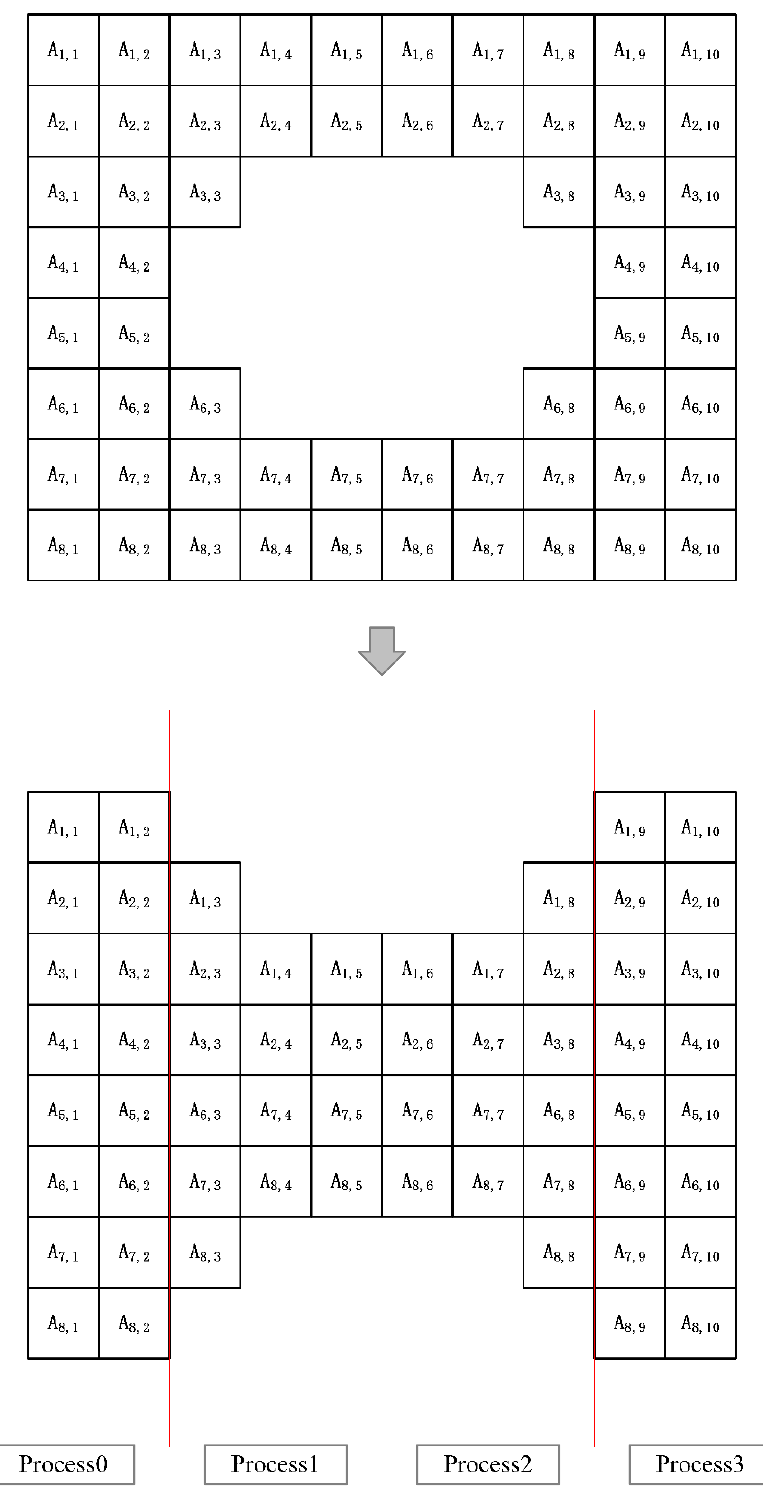
Figure 9. There is a total of 60 grid points in the first layer of grid, so assuming that the number of processes of MPI is 4, each process should normally be divided into 15 grid points. However, for the convenience of description, a one-dimensional division method is used on the single-layer grid here. According to the first-layer grid structure in Figure 8, it can be divided into 4 patches, and the left and right patches are 16 grids. The two patches are 14 grids, so the number of grid points processed by each process can be basically kept the same.